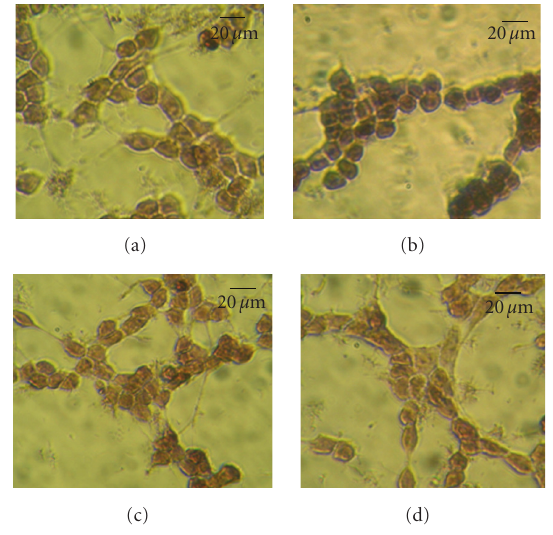
Figure 2: Protective e ff ect of insulin against rA β 42 oligomers induced apoptosis. LAN5 untreated cells as control (a), treated with rA β 42 oligomers (40 μ M) for 1 h (b), with rA β 42 (40 μ M) for 1 h and with insulin (100 μ M) for 20 h (c), insulin alone (100 μ M) for 20 h (d) were fixed and put through TUNEL assay. Bar 20 μ